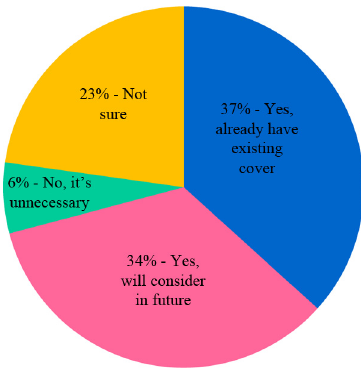
Figure 8. Composition